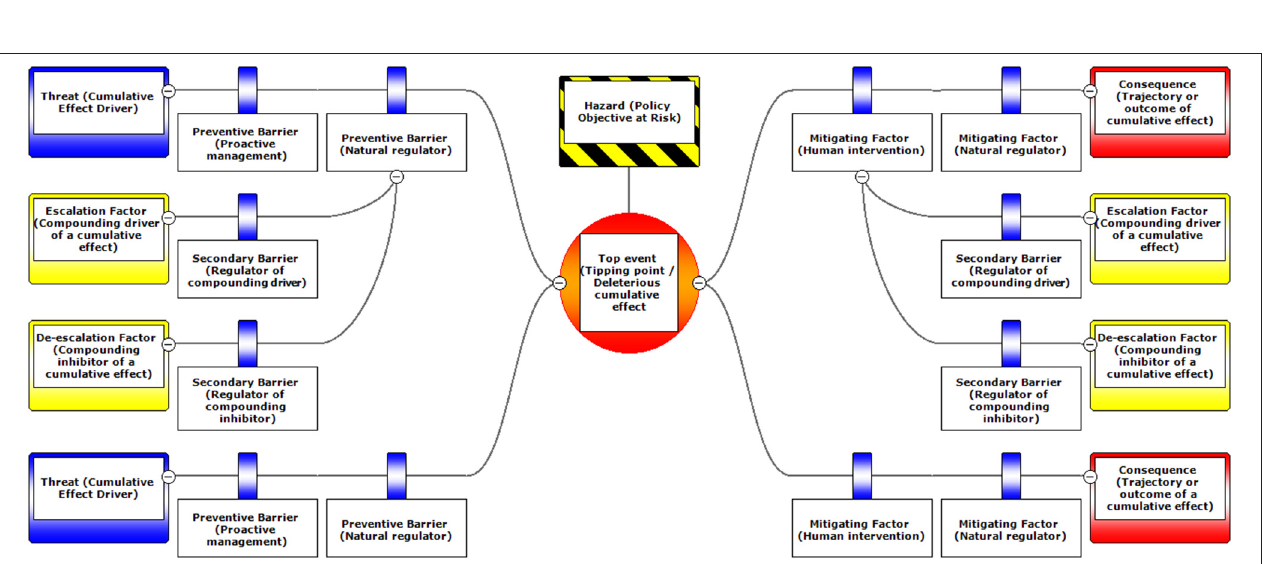
Frontiers in Ecology and Evolution |